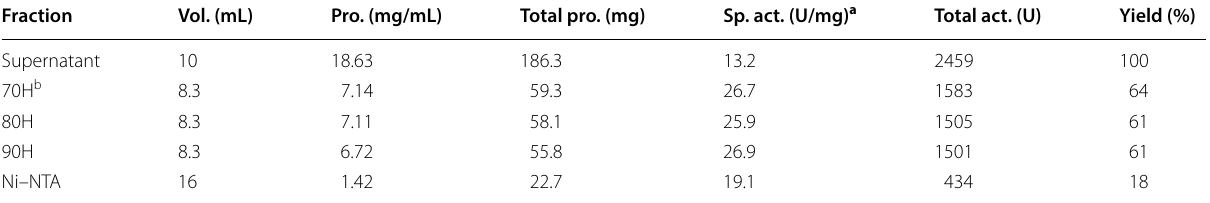
Table 1 Purification of AfPase from 300 mL of the E. coli culture